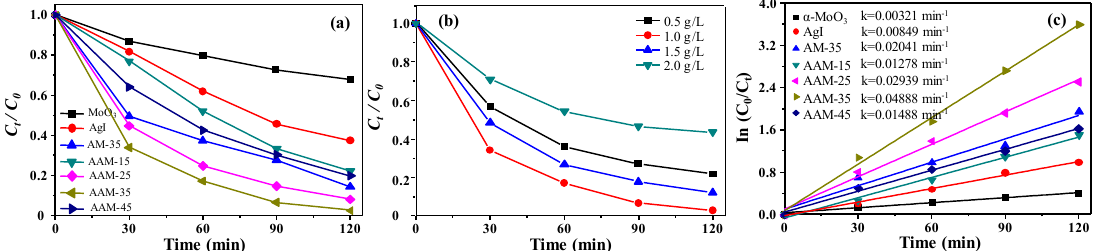
Figure6. Photocatalyticperformancesof α -MoO 3 , AgIandAAMheterojunctions, ( a )thedesulfurization Figure 6. Photocatalytic performances of α -MoO 3 , AgI and AAM heterojunctions, ( a ) the e ffi ciency of di ff erence catalyst, ( b ) the first-order kinetic fit for photodegradation for thiophene, desulfurization efficiency of difference catalyst, ( b ) the first-order kinetic fit for photodegradation for ( c ) recycling run experiments of thiophene, ( c ) recycling run experiments of catalyst.